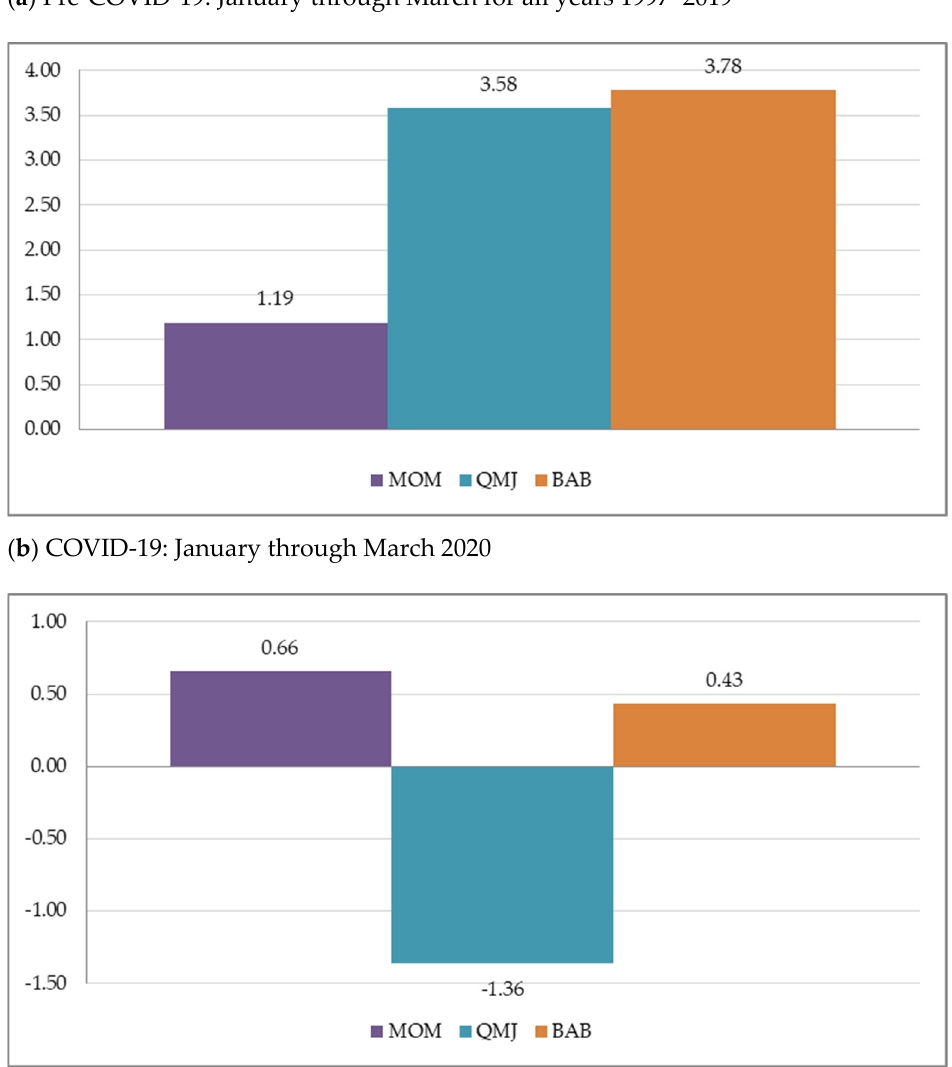
Figure 3. t -Statistics for the Fama–French Alphas for the Other Risk Factors: Global Index. This figure displays t -statistics for testing the significance of the intercept from a regression of either the momentum factor (MOM), the quality factor (QMJ), or the betting-against-beta factor (BAB) on the three factors of the Fama–French (1993) model for the global international stock market index. ( a ) shows the results when using monthly data for the first quarter of each of the years between 1997 and 2019. ( b ) shows the results when using daily data for the subperiod affected by the first impact